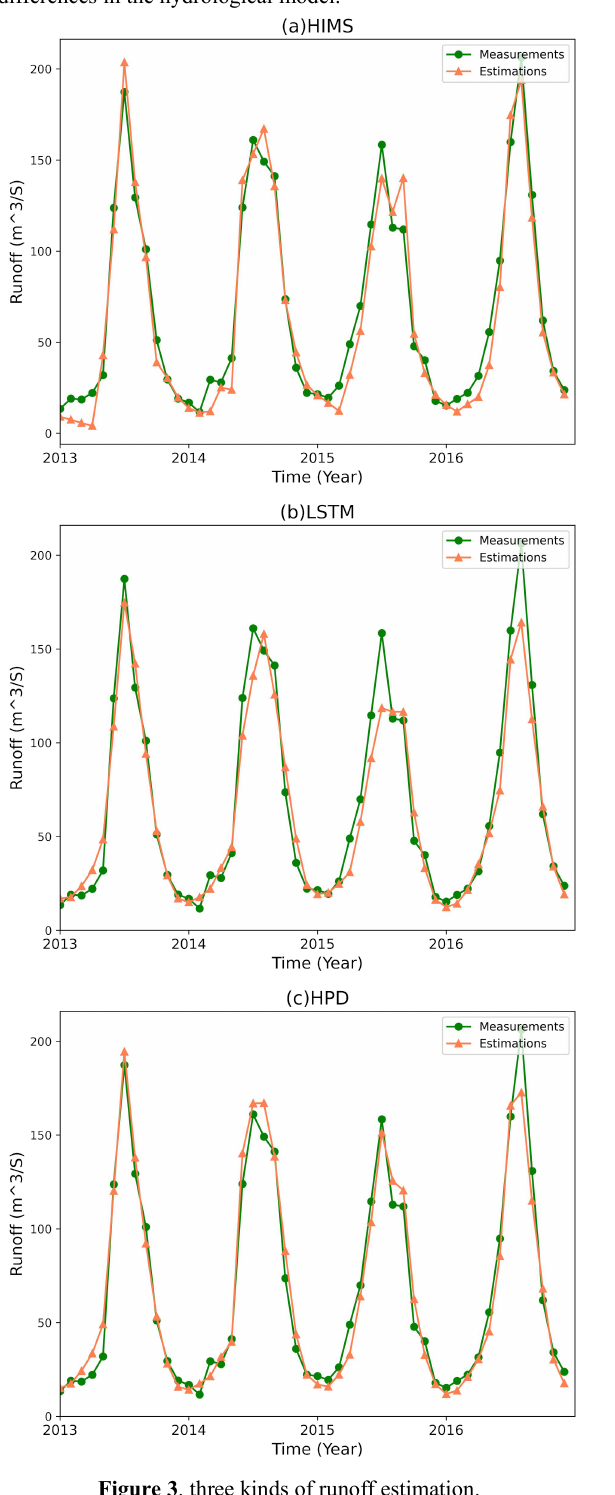
Figure 3 . three kinds of runoff estimation.